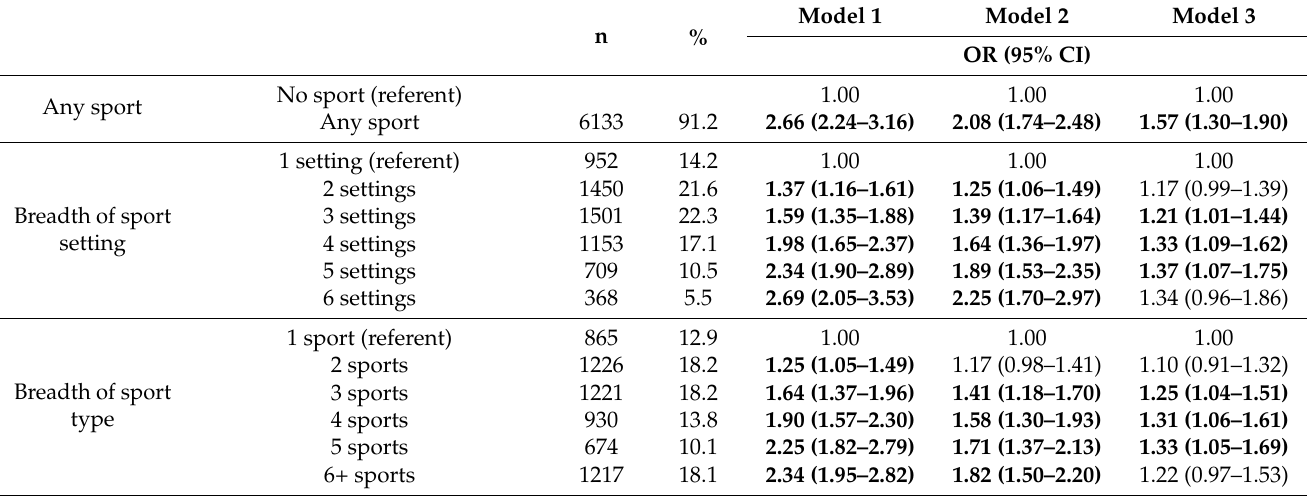
Table 2. Association between sport participation breadth and wellbeing (n =